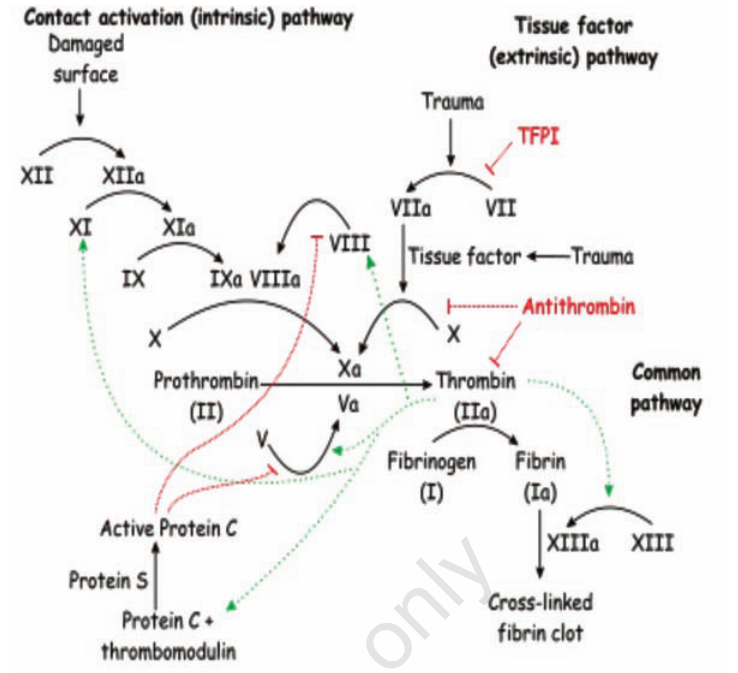
Figure 8. The Coagulation Cascade. 72 Legend: this is the physiological coagulation cas- cade used to describe a very complex step-by-step process that occurs in the body ( in vivo ) when a blood vessel is injured. In the cascade, solid arrows indicate activation of a coagu- lation factor by the factor above it in the cascade, dotted arrows indicate activation of fac- tors V, VIII, XI and XIII by thrombin. The intrinsic cascade (which has less in vivo signif- icance in normal physiological circumstances than the extrinsic cascade) is initiated when contact is made between blood and exposed negatively charged surfaces. The extrinsic pathway is initiated upon vascular injury which leads to exposure of tissue factor, TF (also identified as factor III), a subendothelial cell-surface glycoprotein that binds phospho- lipid. The green dotted arrow represents a point of cross-over between the extrinsic and intrinsic pathways. The two pathways converge at the activation of factor X to Xa. Factor Xa has a role in the further activation of factor VII to VIIa as depicted by the green arrow. Active factor Xa hydrolyzes and activates prothrombin to thrombin. Thrombin can then activate factors XI, VIII and V furthering the cascade. Ultimately the role of thrombin is to convert fribrinogen to fibrin and to activate factor XIII to XIIIa. Factor XIIIa (also termed transglutaminase) cross-links fibrin polymers solidifying the clot. HMWK =